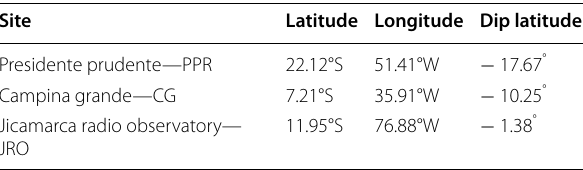
Table 2 Location of ScintPi 3.0 receivers whose data is used